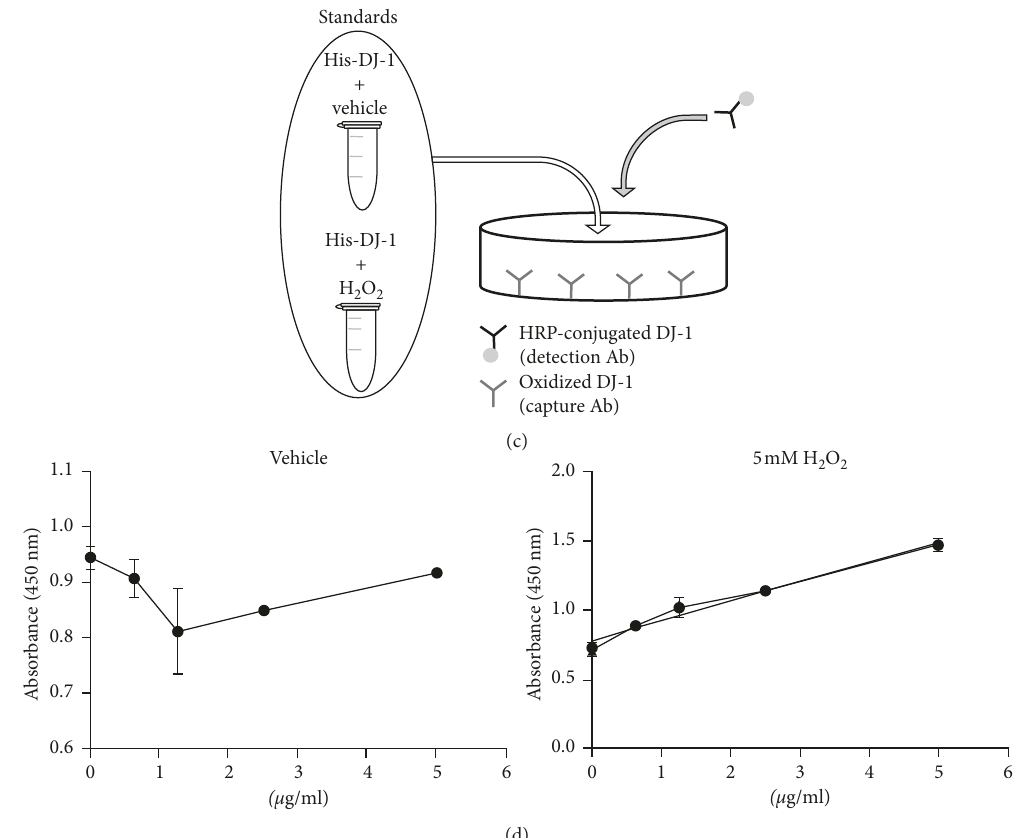
Figure 1: Establishment of the OxiDJ-1 ELISA. (a) Western blot analysis of OxiDJ-1. To generate OxiDJ-1, His-DJ-1 was incubated with 5mM H 2 O 2 or equivalent vehicle (sterile DW) for 1.5h at 37 ° C and subjected to the Western blot analysis. (b) A quantitative analysis using a densitometer of the Western blot results in high molecular weight (HMW), or monomer was indicated by closed bracket or arrowhead, respectively. (c) A schematic diagram representing our OxiDJ-1 ELISA. (d) The standard curve obtained from the OxiDJ-1 ELISA. The ELISA was performed with an oxidized DJ-1 antibody as a capture antibody and HRP-conjugated DJ-1 antibody as a detection antibody using His-DJ-1 pretreated with H 2 O 2 or DW as standard